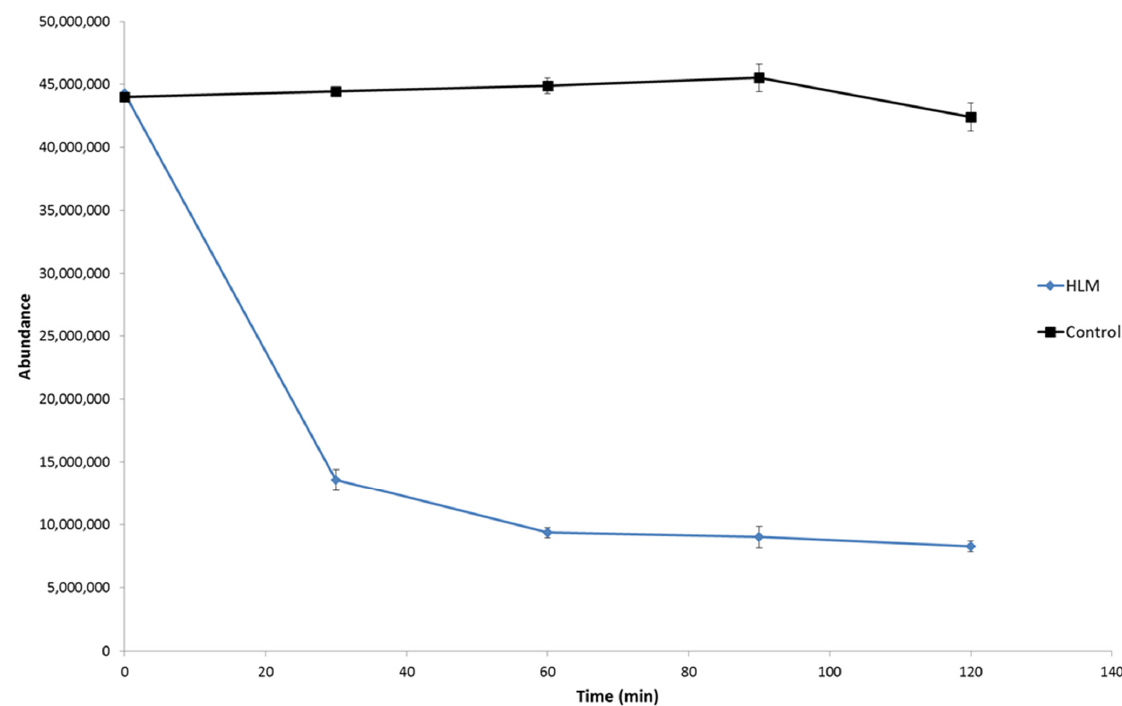
Figure 2. Biotransformation of dapoxetine in HLM (presented as the function of time; error bars represent the standard deviation of the mean, n = 3).